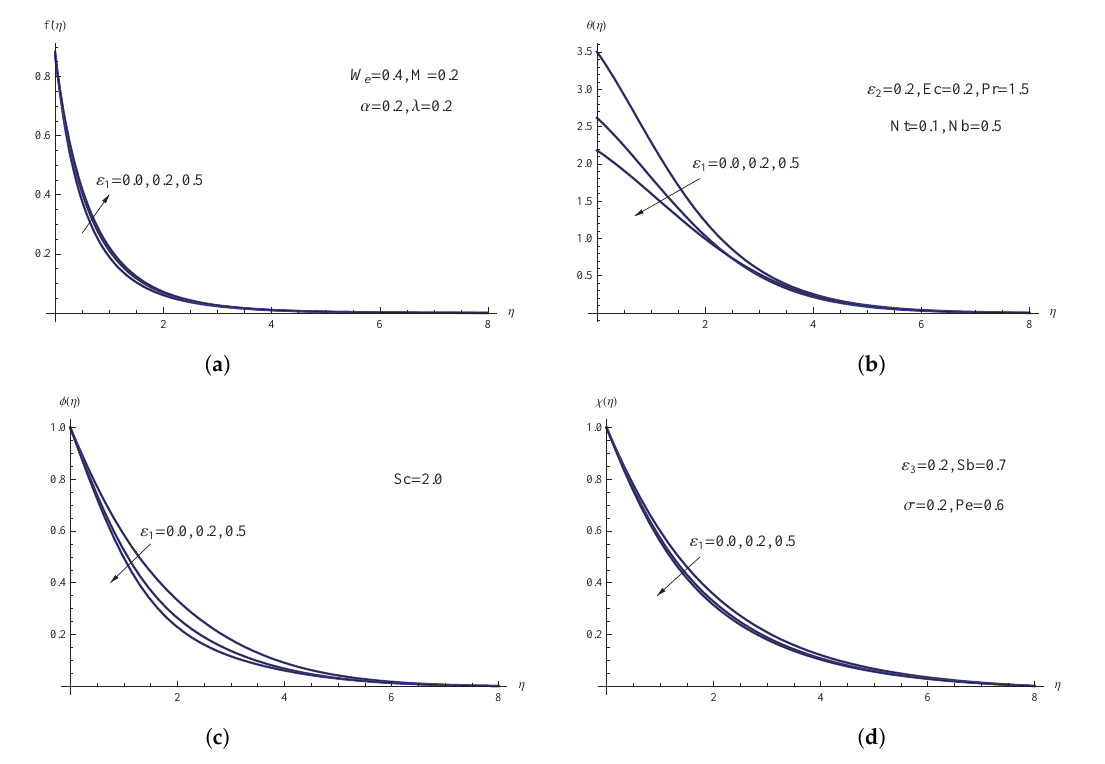
Figure 5. ( a ) f (cid:48) ( η ) for various ε 1 . ( b ) θ ( η ) for various ε 1 . ( c ) φ ( η ) for various ε 1 . ( d ) χ ( η ) for various ε 1 . Figure 6 elucidates the physical aspects’ impact of the mass diffusivity parameter ε 2 on both the concentration φ ( η ) and microbe species concentration χ ( η ) profiles, respectively. Clearly, both φ ( η ) and χ ( η ) present an enhancing variation with the presence of the mass diffusivity parameter ε 2 . Likewise, Figure 7a depicts the variations in the temperature pro- file θ ( η ) as a function of ε 2 . When the mass diffusivity value ε 2 is increased, the magnitude of the sheet temperature θ ( 0 ) is clearly restricted, and it is dramatically intensified as this parameter is increased. The changes in the microbe species concentration profile χ ( η ) as a function of the microorganism diffusivity parameter ε 3 are shown in Figure 7b. It is revealed that increasing the microorganism diffusivity parameter improves the behavior of the microbe species concentration profile considerably. In terms of physics, this means that the microorganism diffusivity parameter is what causes the microbe concentration layer to thicken.